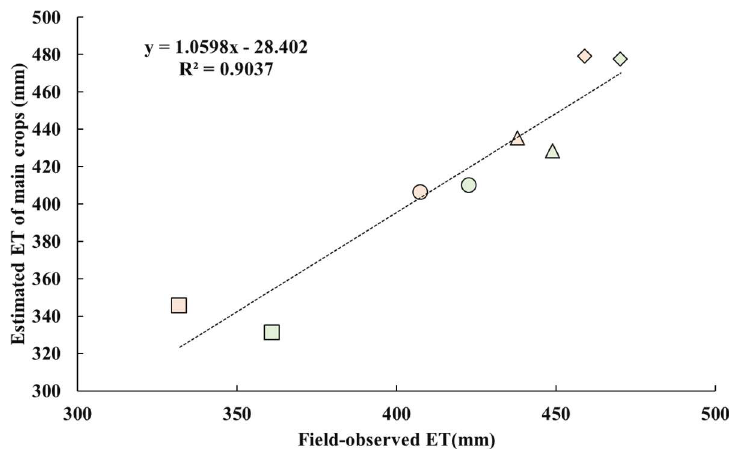
Figure 4. A comparison of estimated and field-observed evapotranspiration (ET) of the main crops in Hengshui.